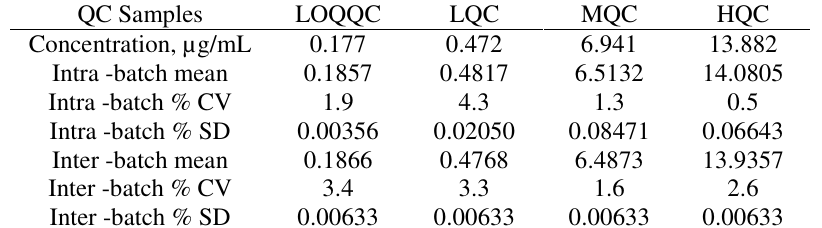
Table 1. Intra & inter-batch precision & accuracy of fenofibric acid in human plasma.